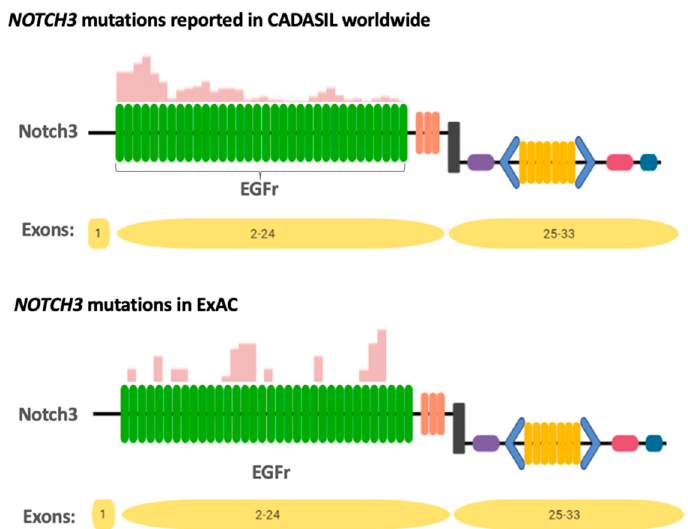
Figure 3. Distribution of different EGFr cysteine altering NOTCH3 mutations in ExAC (currently called gnomAD) compared with those reported in cerebral autosomal dominant arteriopathy with subcortical infarcts and leukoencephalopathy (CADASIL) patients. Figure adapted from Rutten et al. (2016)